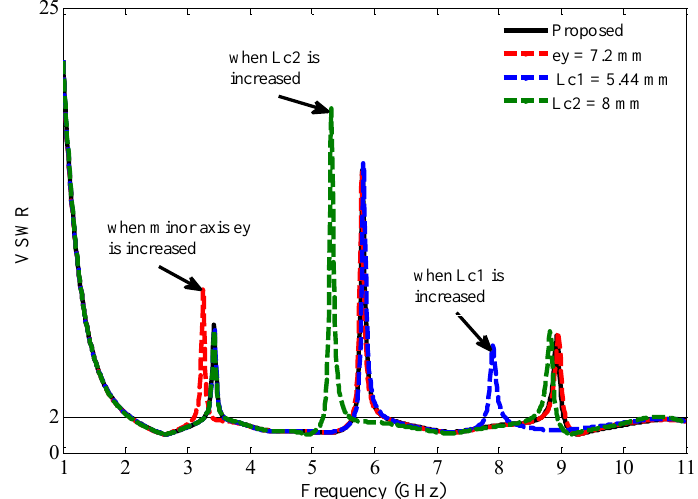
Figure 10. Parametric study of the resonator.